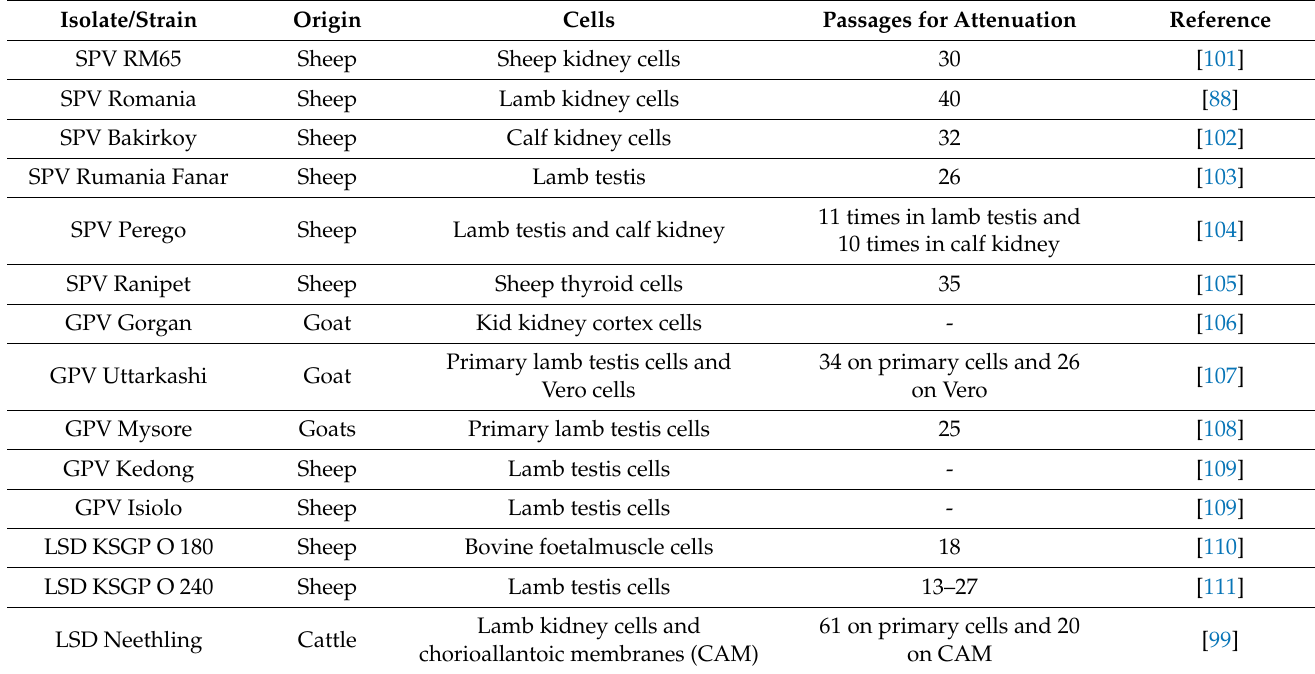
Table 1. Capripoxvirus strains reported in the